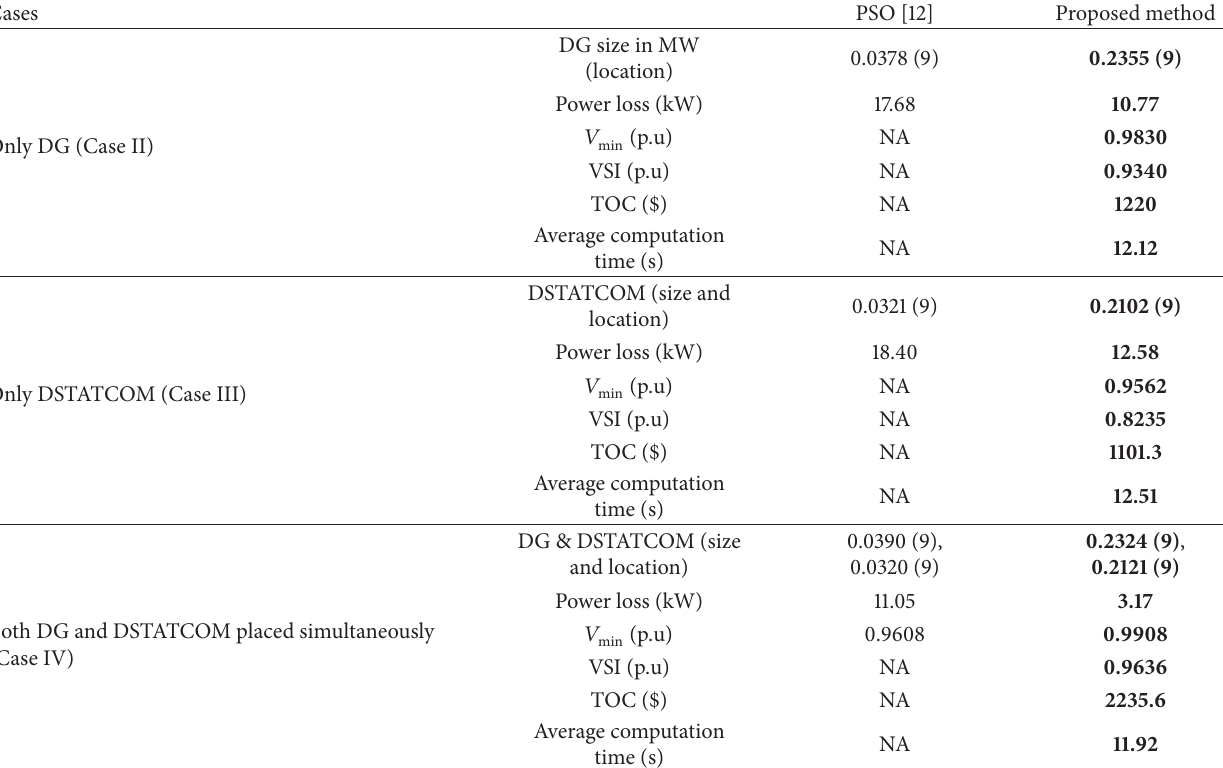
Table 1: Result of 12-bus